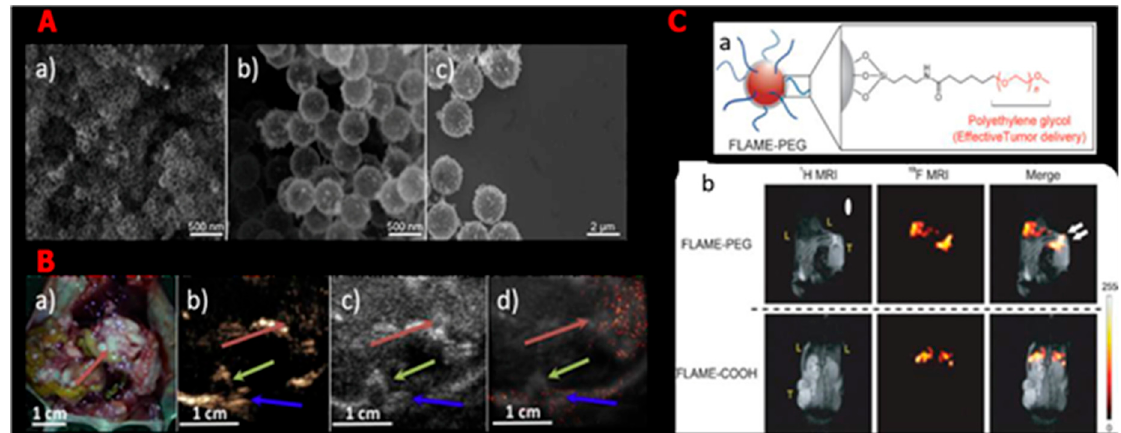
Figure 1. Silica nanoparticles used as contrast agents for ultrasound and magnetic resonance imaging. ( A ) SEM images of porous hollow silica nano- and microshells having different particle size: ( a ) 100 nm, ( b ) 500 nm, and ( c ) 2000 nm. (Reproduced from Reference [32] with the permission of Elsevier Ltd.) ( B ) Ultrasound imaging of gas-filled silica microshells present in tumor-bearing mice; ( a ) intraperitoneal IGROV-1 ovarian tumor in the dissected nu/nu mouse, ( b ) Cadence contrast pulse sequencing (CPS) image, and ( c ) B-mode image of the particles through the tumor cross-section one (1) hour post injection with silica nanoparticles, ( d ) overlay of CPS image and B-mode image (red arrow = tumor, green arrow = spinal column, blue arrow = bottom of the mouse). ( C ) In vivo accumulation of silica nanoparticles at tumor site; ( a ) structural diagram of functionalized silica nanoparticles, ( b ) in vivo MRI of functionalized silica nanoparticles in tumor-bearing mice. Liver and tumor sites are indicated as L and T, respectively. Reproduced from Reference [33] with the permission of Wiley-VCH Verlag GmbH & Co. KGaA, Weinheim.